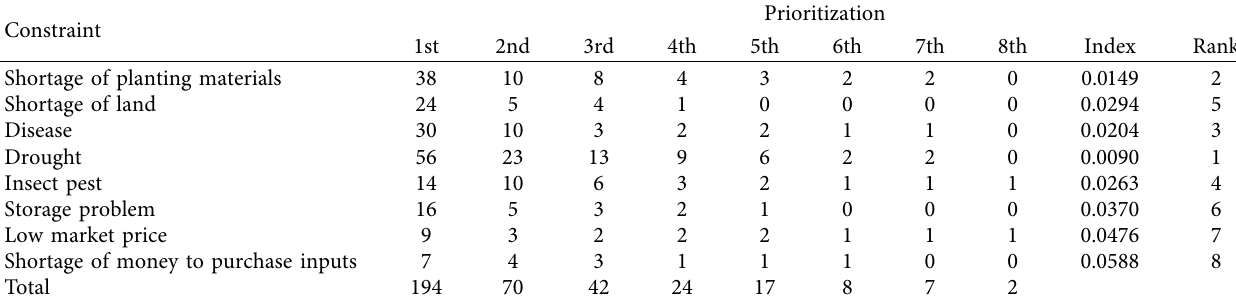
Table 5: The area’s major orange-fleshed sweet potato production